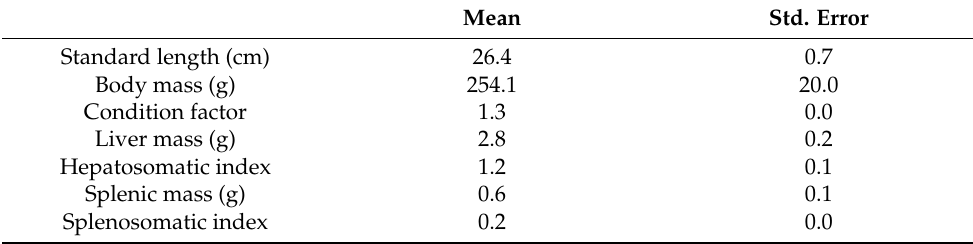
Table 1. Mean and standard error of fish biometrics. Mean Std. Error Standard length (cm) 26.4 Body mass (g) 254.1 20.0 Condition factor 1.3 0.0 Liver mass (g) Hepatosomatic index Splenic mass